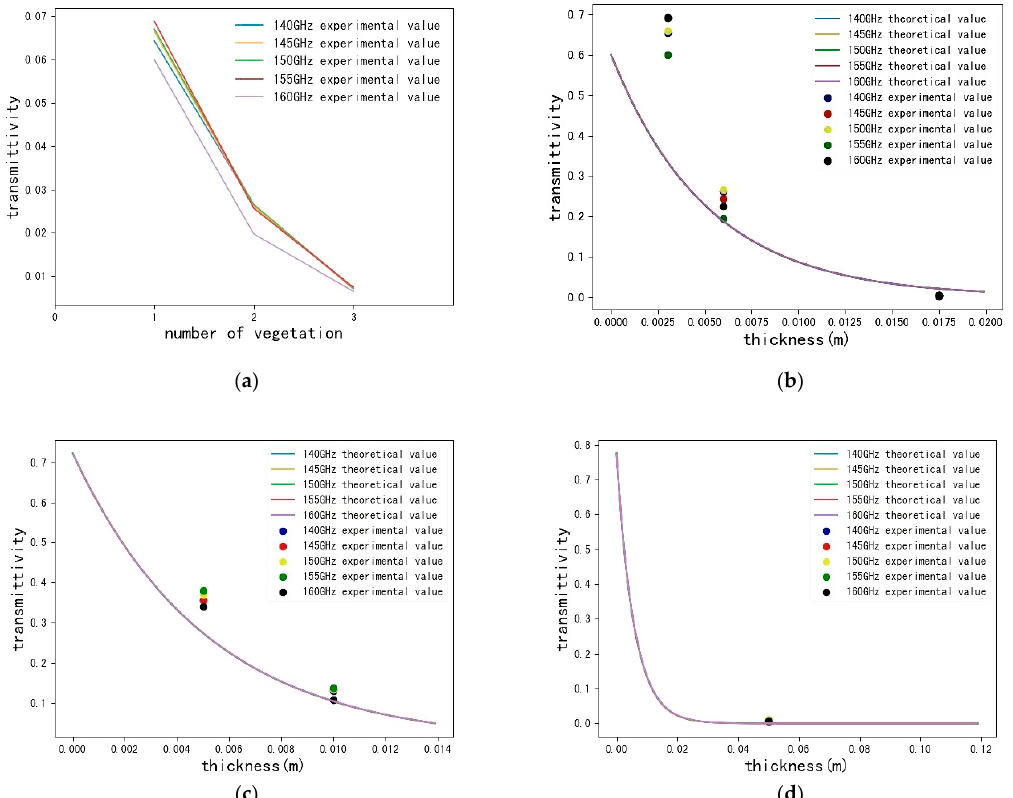
Figure 9. Theoretical and actual transmittance of D-band millimeter-wave signal passing through the obstruction: ( a ) the relationship between the actual transmittance and the amount of vegetation at different frequencies; ( b ) the relationship between the theoretical and actual transmittance and the thickness of board at different frequencies; ( c ) the relationship between the theoretical and actual transmittance and the thickness of glass at different frequencies; ( d ) the relationship between the theoretical and actual transmittance and the thickness of slate at different frequencies. Since vegetation is not comparable the other three typical building materials, param- eters such as relative permittivity can be queried, so the theoretical transmittance of veg- etation is not listed here. In Figure 9a, only the transmittance of vegetation measured ex- perimentally is plotted.